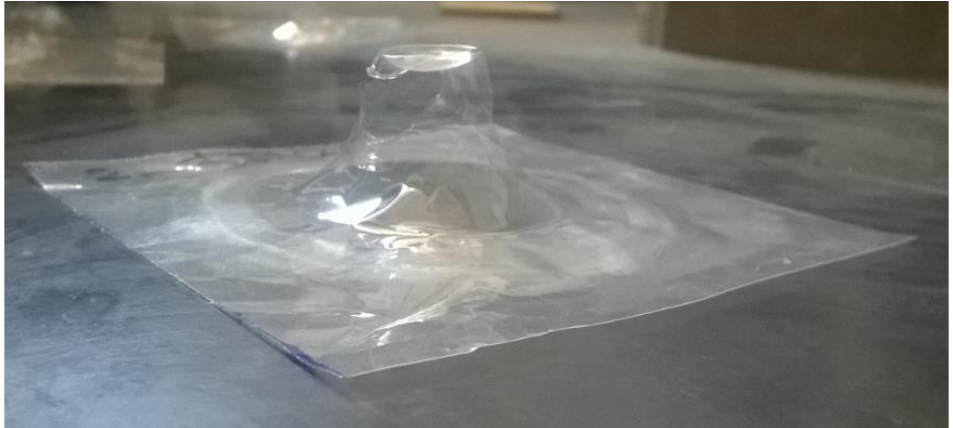
Figure 9. Specimen of ETFE after the impact test, at Energy = 1.54 J.